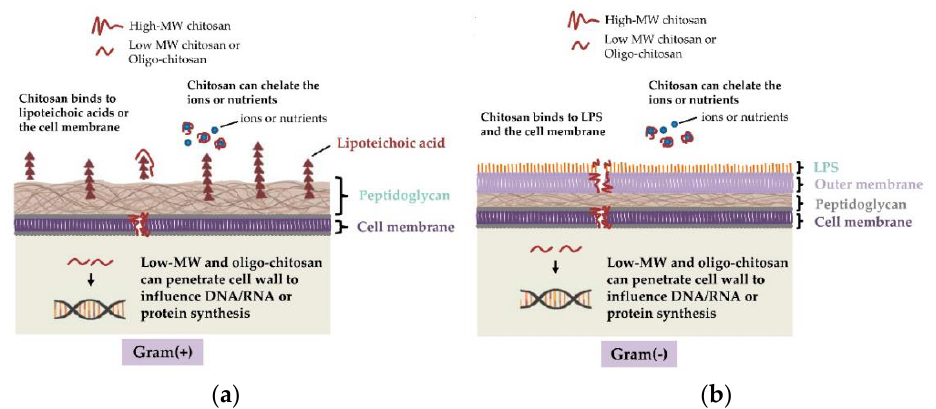
Figure 5. ( a ) Mechanism of attack of chitosan on the bacterial cell wall of Gramm-positive and Gramm-negative bacteria. Adapted from [136], originally published under a CC-BY 4.0 license. ( b )